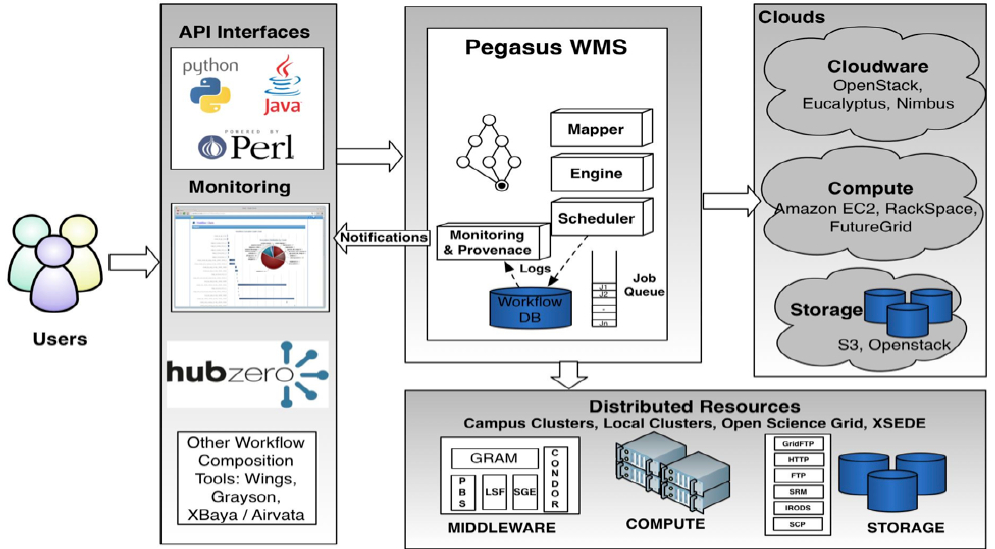
Figure 6. Pegasus architecture [34].